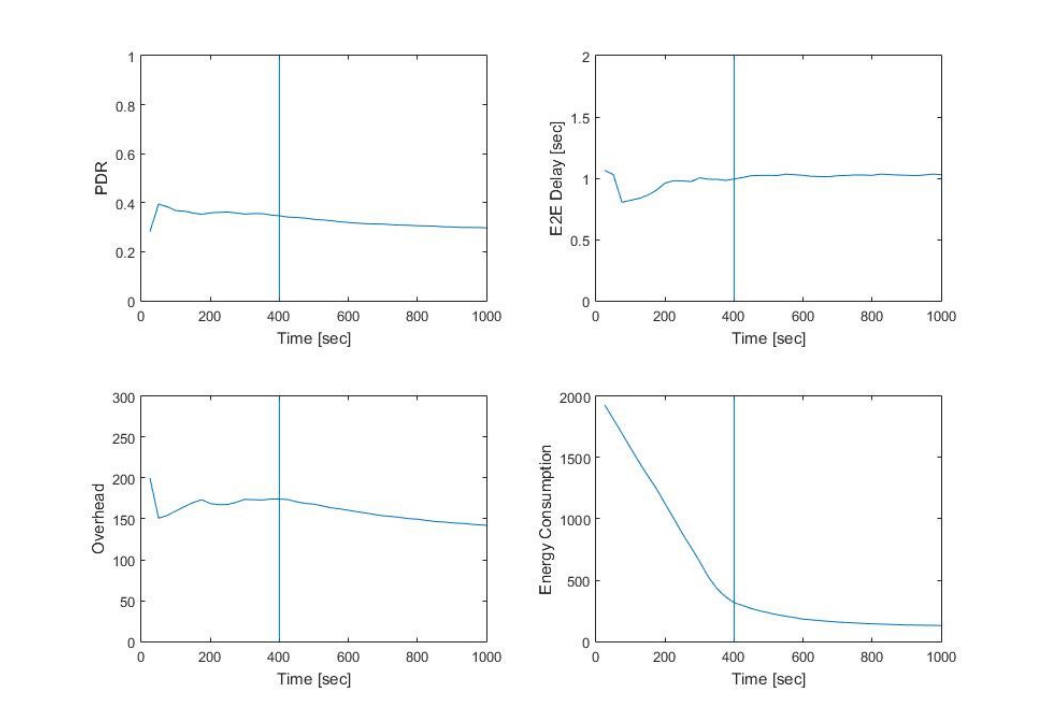
Fig. 7. Evaluation of OLSR protocol based on 50 mobile sensor